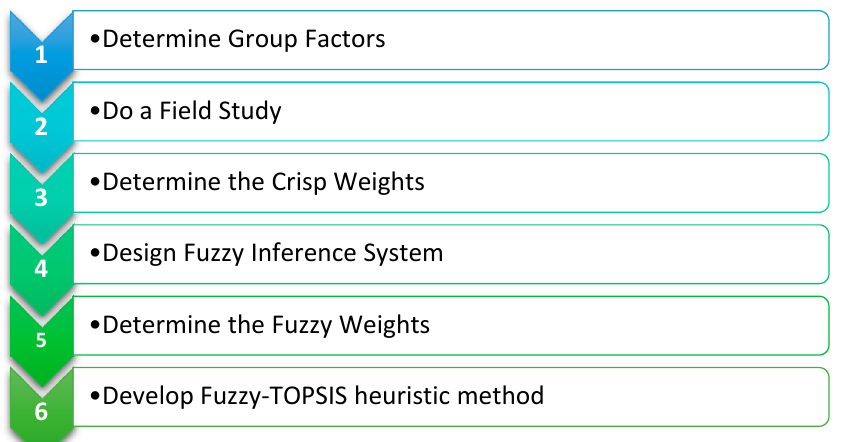
Figure 6. Flow diagram of extracting data from statistical society and using it in the proposed fuzzy–TOPSIS method.